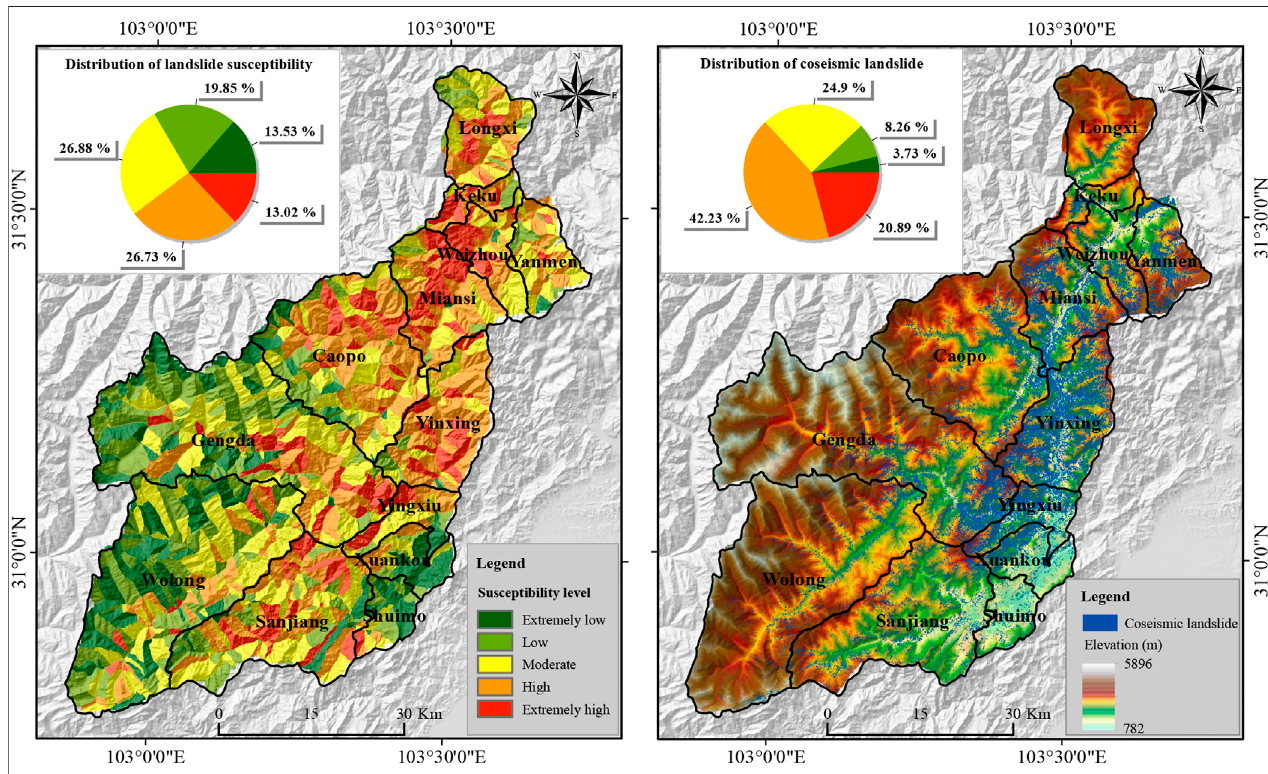
FIGURE 6 | Landslide susceptibility map generated by